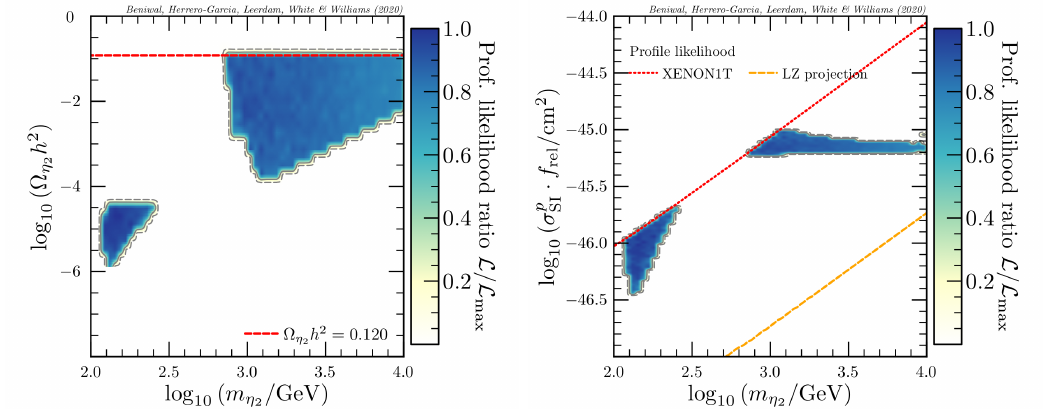
Figure 2 . 2-dimensional (2D) plots of profile likelihood ratio (PLR) for the scalar singlet η 2 relic density ( left panel ) and spin-independent (SI) η -proton direct detection (DD) cross section ( right 2 panel ), scaled by the DM fraction, f rel = Ω η / 0 . 120 , for the case of θ = 0 in Normal Ordering 2 (NO). The dashed (dotted) red lines in the left (right) panel show the Planck measured DM abundance [53] (official XENON1T exclusion limit [57]), whereas the projected LZ sensitivity [75] is shown as dashed orange line in the right